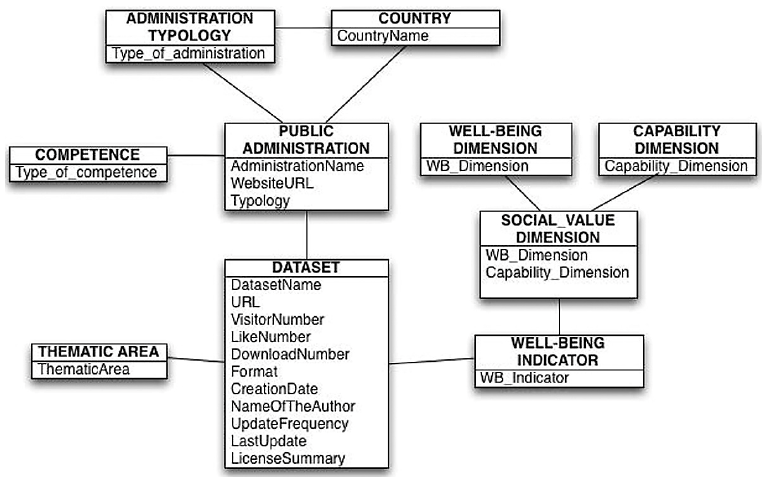
Figure 1. Conceptual schema of the repository for data collection supporting the social value